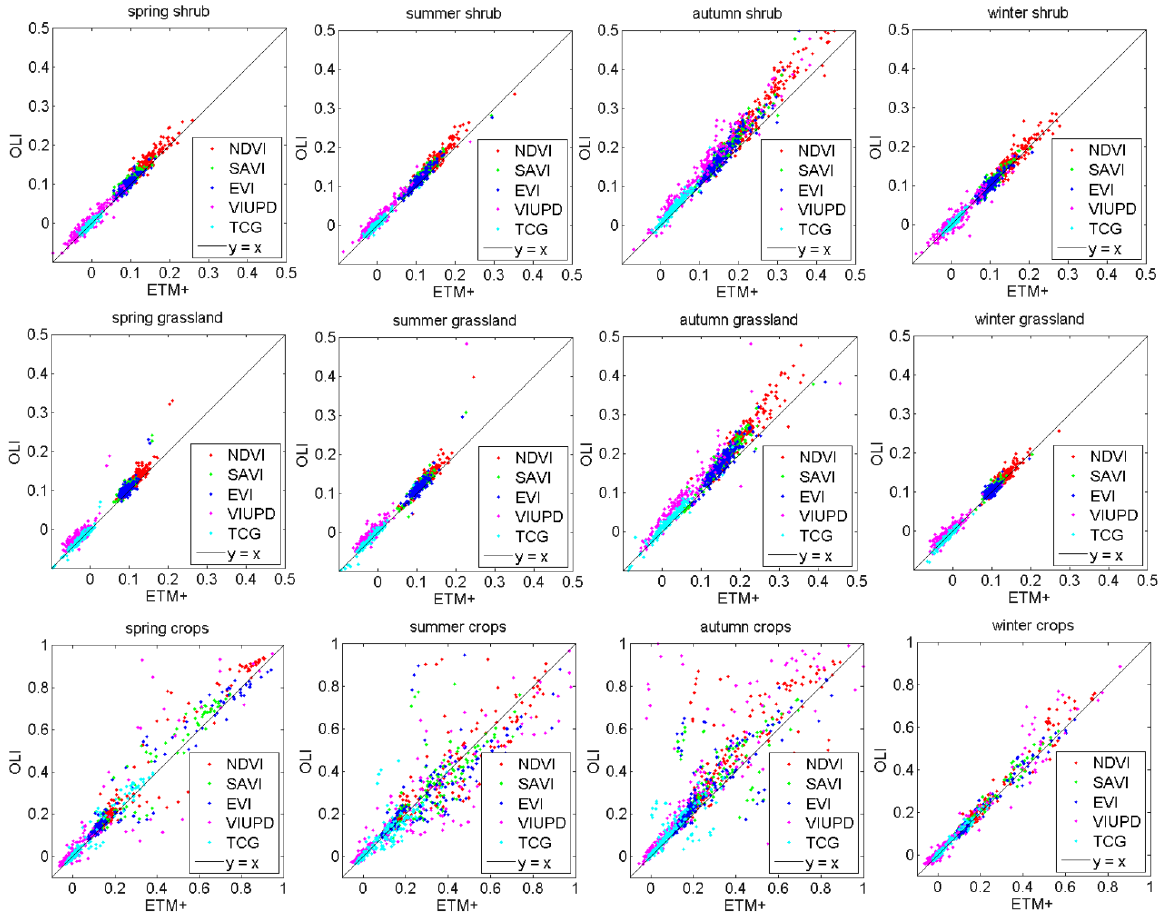
Figure 8. Scatterplots showing the correlational relationships among five VIs as derived from Landsat 7 ETM+ and Landsat 8 OLI data for three non-forest types during the four seasons. Among the 12 scatterplots, shrub, grassland, crops are shown on the vertical axis, with spring, summer, autumn, and winter on the horizontal